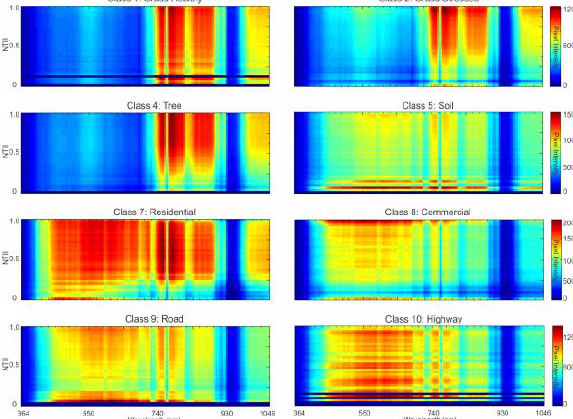
Figure 3. Ratio between the in-shadow and not in-shadow pixel intensities vs. the wavelength. The in-shadow pixels clearly appear more bluish and less reddish than the not in-shadow pixels The curve in Figure 3 confirms that the indirect component of